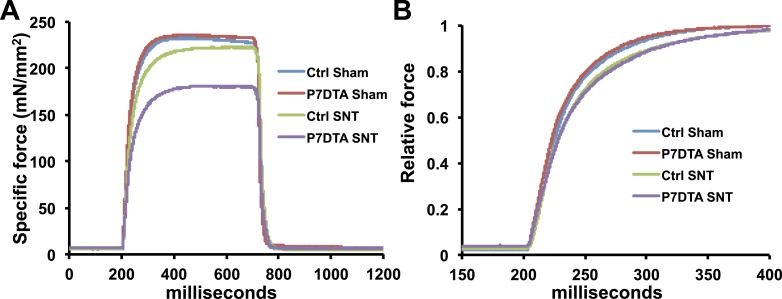
Reduced contractile force and slowed force development in EDL muscles following SNT.(A). Representative traces for specific force from in vitro muscle contraction measurements in EDL muscles stimulated at 150hz for 500ms. (B). Same traces as (A) but normalized to the corresponding peak and expanded for the first 200ms of stimulation to show the delayed force development in muscles following SNT.